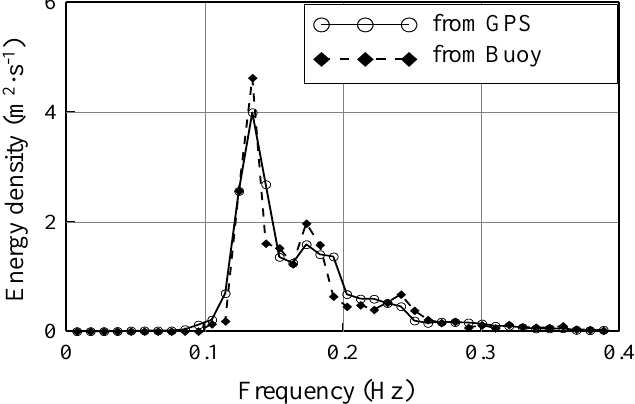
Figure 12. Comparison of the GPS-derived and buoy-measured frequency spectrum (Data: 2006/12/21 12:00, Hs = 1.4